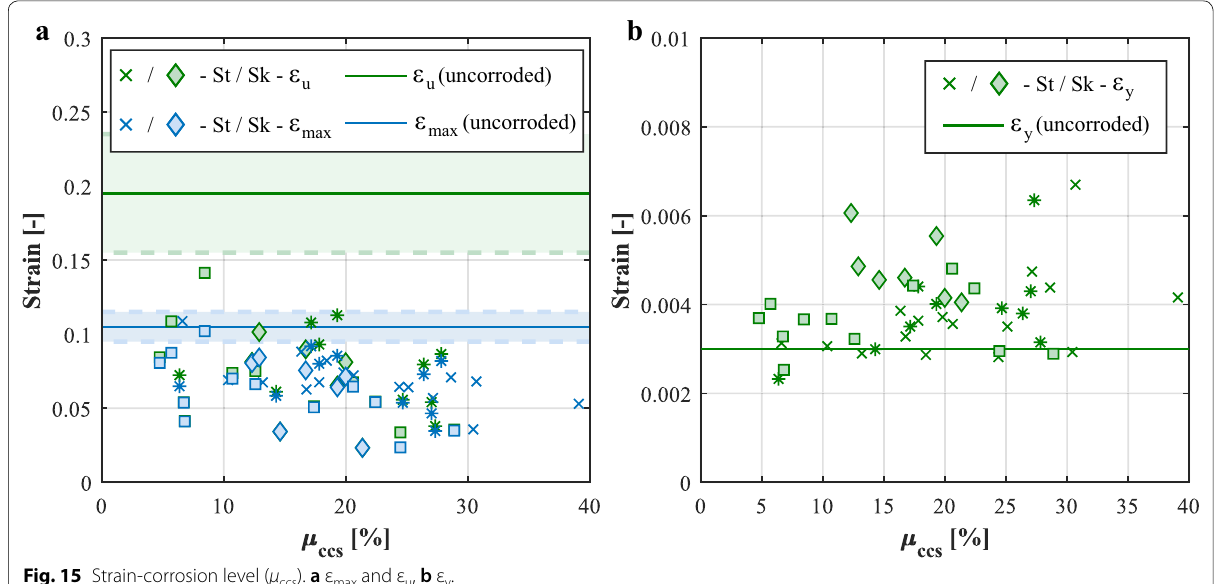
Fig. 15 Strain-corrosion level ( μ ccs ). a ε max and ε u , b ε y